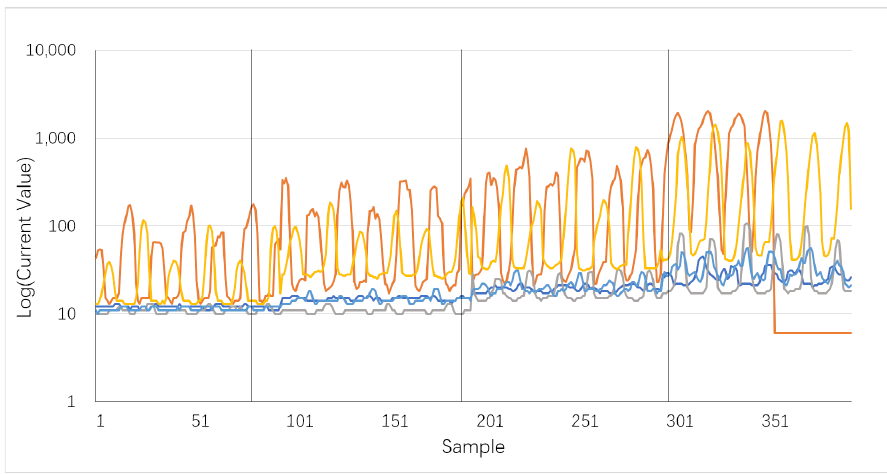
Figure 17. Current signal when the egg produced the discharge phenomenon at different voltages.